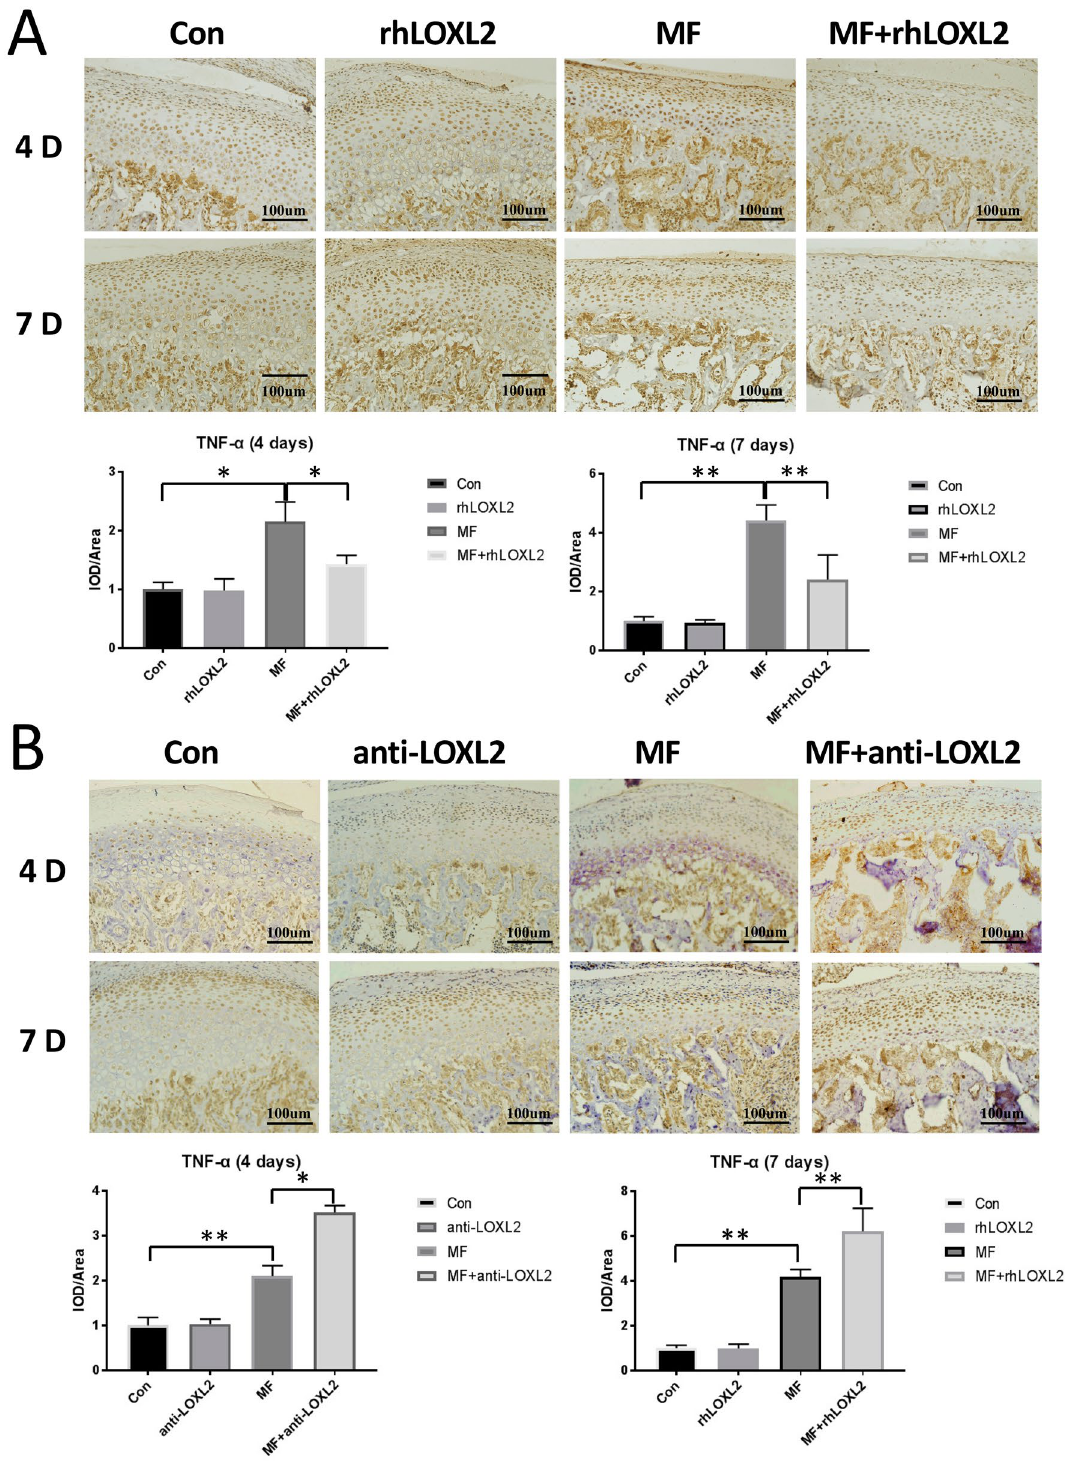
Figure 5. LOXL2 restored TNF-a over-expression in mandibular condyle cartilage at 4 and 7 d after force application. Immunohistochemical analysis of TNF-a expression and quantification of it in chondrocytes from samples treated as indicated at 4 or 7 d after force application (n = 12). ( A ) Degradation of TNF-a in MF groups (4-days, p < 0.05; 7-days, p < 0.01; compared with the controls) was recovered by rhLOXL2 (4-days, p < 0.05; 7-days, p < 0.01; compared with the MF groups), ( B ) while worsened by anti-LOXL2 (4-days, p < 0.05; 7-days, p < 0.01; compared with the MF